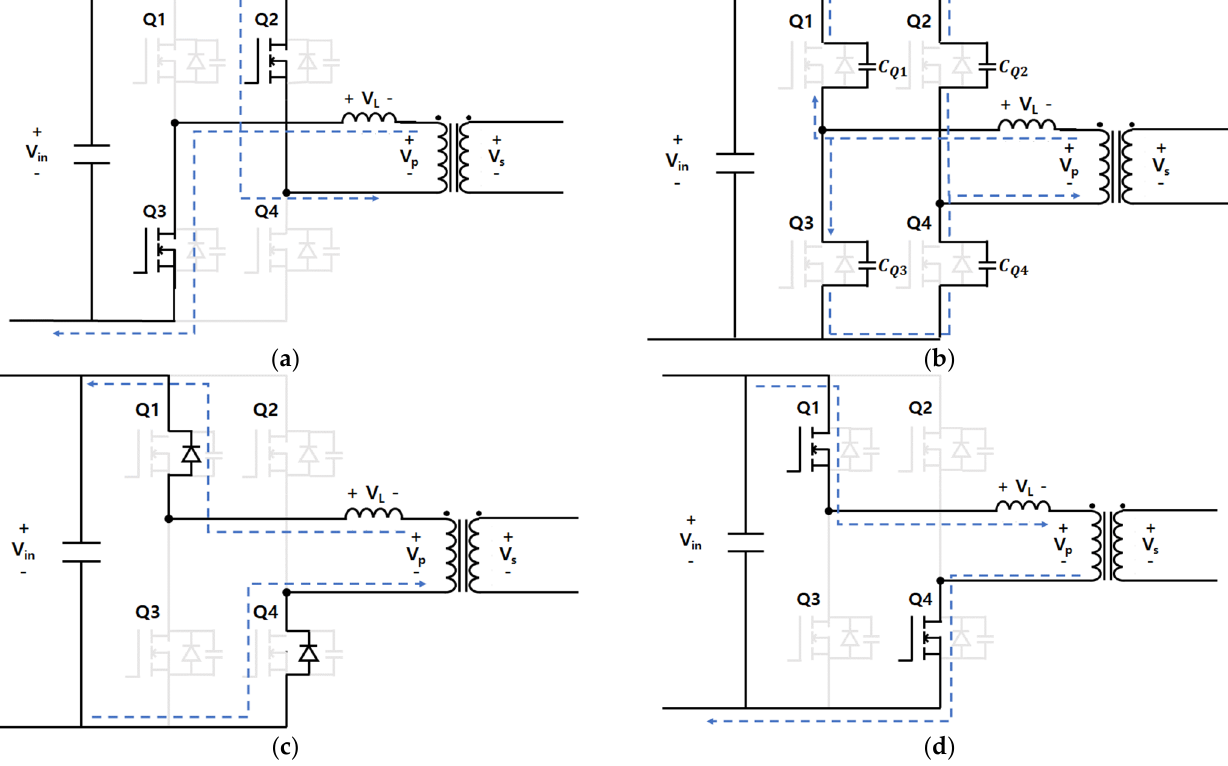
Figure 4. Equivalent circuit according to switching operation: ( a ) Q2,Q3 switches ON, Q1,Q4 switches OFF; ( b ) operation of parasitic capacitors during dead time; ( c ) operation of switches diode dead time; ( d ) Q1,Q4 switches ON, Q2,Q3 switches OFF.